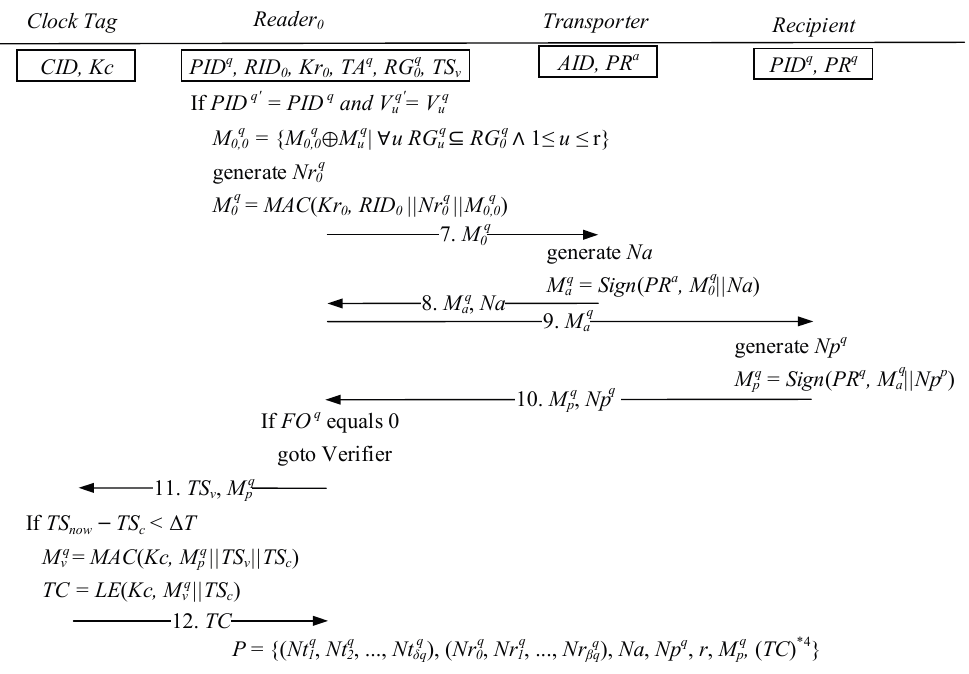
Figure 7. Affirm the tags and proofs signed by both sides and verify the time